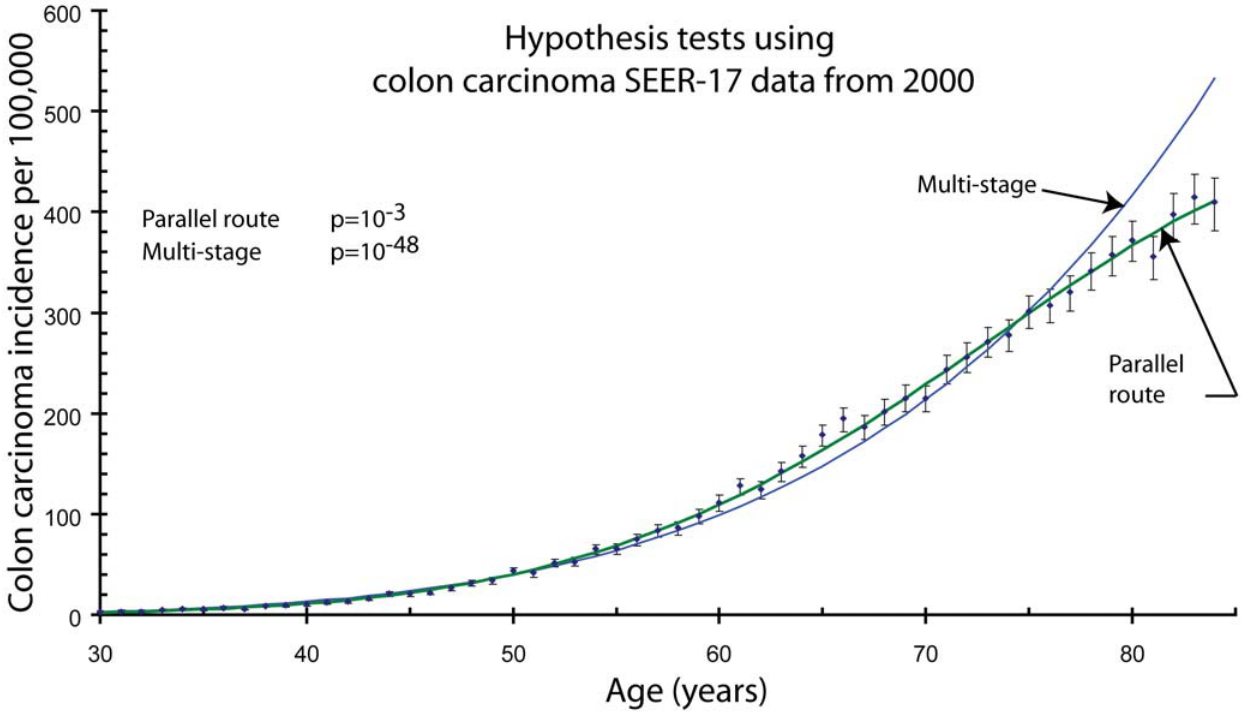
Figure 1. This graph compares two different hypotheses for the development of carcinoma with the age-specific incidence data. The multi-stage hypothesis, as represented by the Armitage-Doll model, Equation 2 [51], and parallel route hypothesis, represented by Equation 3. The Armitage-Doll model is an approximation of the differential form of the Poisson process, Equation 1. Using this equation gives p ~ 10 { 17 , a substantially better, but still clearly unacceptable fit. Thus, the parallel route hypothesis is clearly acceptable, while the multi-stage hypothesis is not. The error bars represent 95% confidence intervals in the measured values.